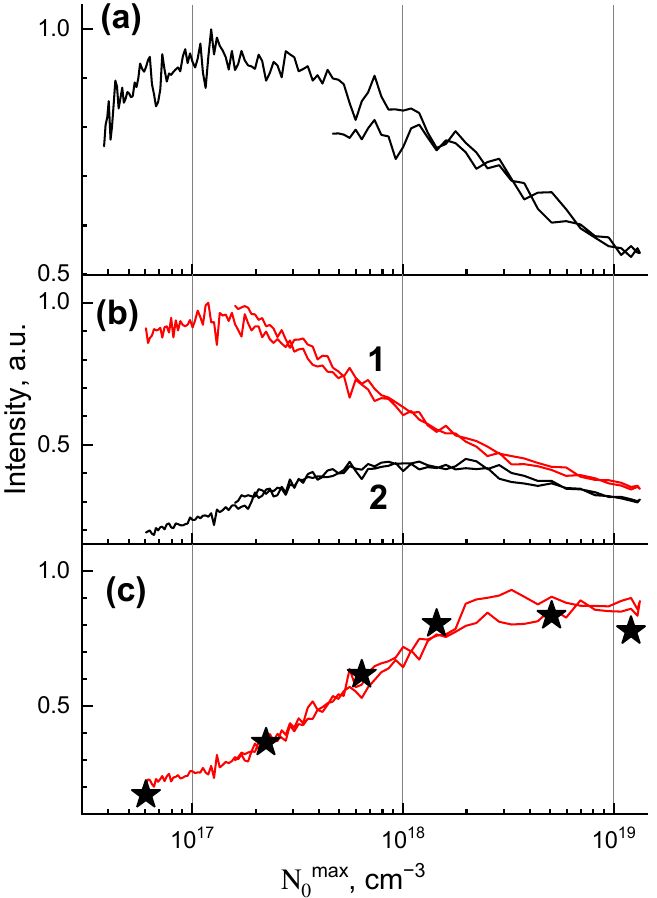
Figure 6. Dependence of GAGG:Ce emission intensity on the excitation density (Z-scan) measured in the whole temporal region ( a ) and in the fast (1) and slow (2) time windows ( b ). The curve ( c ) presents the ratio of dependences measured in slow and fast time windows. The ratio between the amplitudes of fast and slow components of the decay curve fit are given by asterisks.